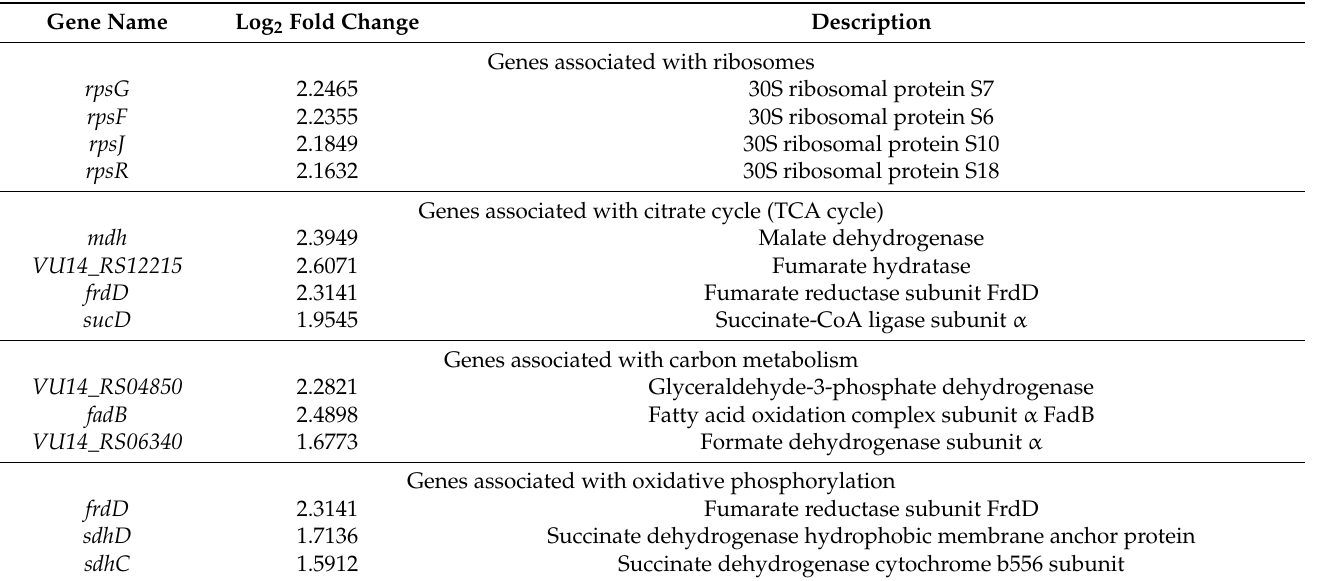
Table 2. The representative upregulated gene